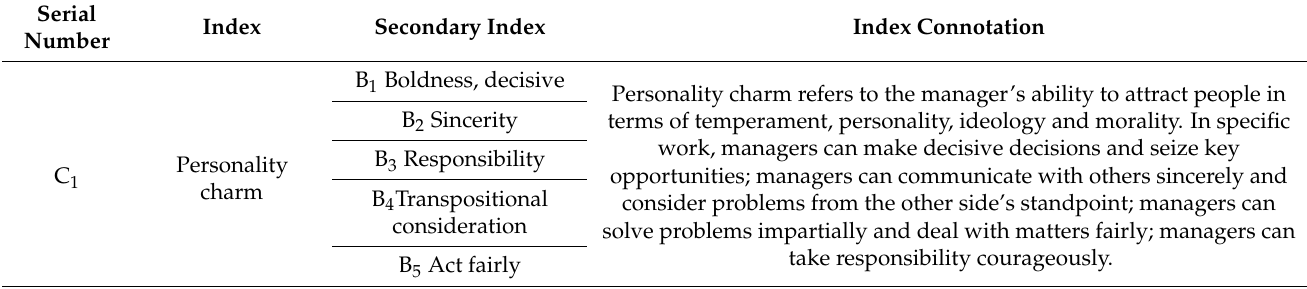
Table 1. Competency model of construction program